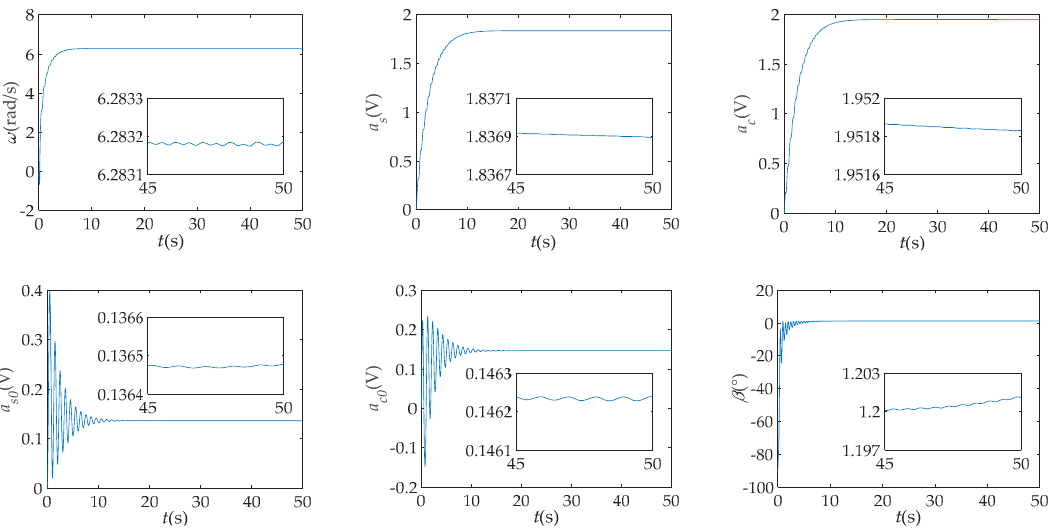
Figure 10. Estimations of angular velocity and imperfect parameters in simulation after the designed filter (Group 4).